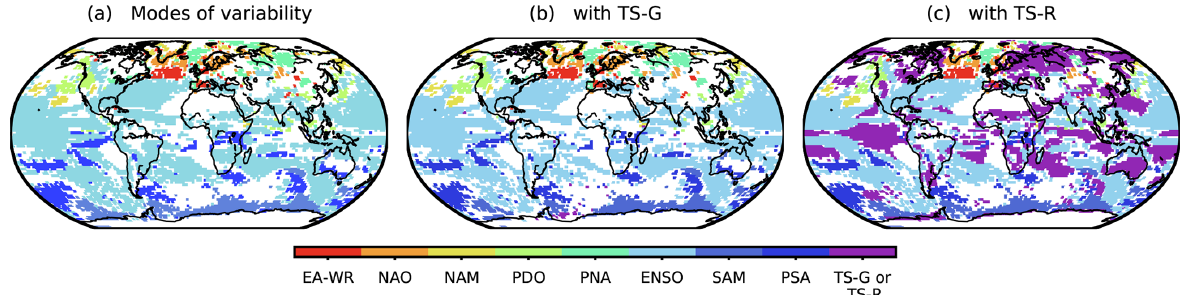
Figure 11. The non-stationary GPD models with (a) the modes of variability, (b) the modes of variability and TS-G, and (c) the modes of variability and TS-R as covariates that outperform all other GPD models (the modes of variability, TS-G or TS-R, and stationary GPD models) at 99% confidence interval hence best explain the variability of extreme precipitation. The regions where both orbital-only and full-forcing simulations share the same statistically significant D statistics are shown. The plots that correspond to each of the simulations can be found in Fig. S7 in the